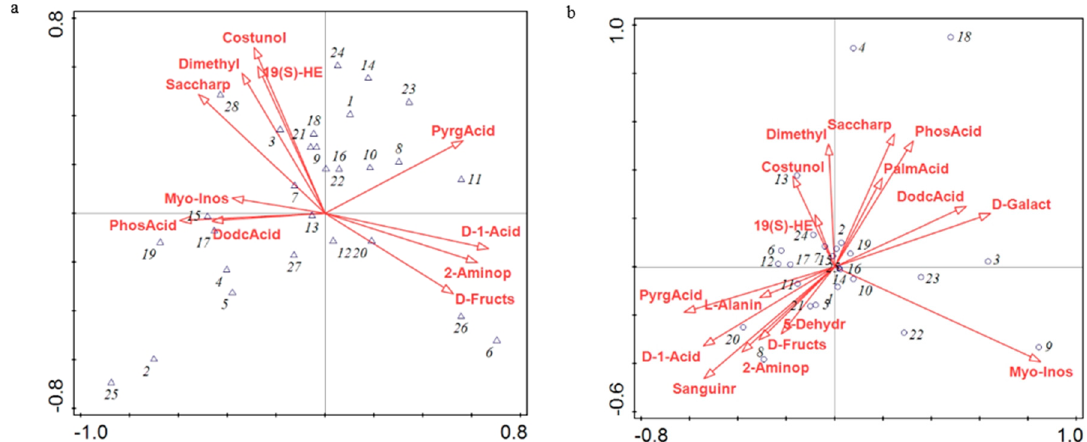
Figure 11. Canonical correspondence analysis of microbial relative abundance and differential